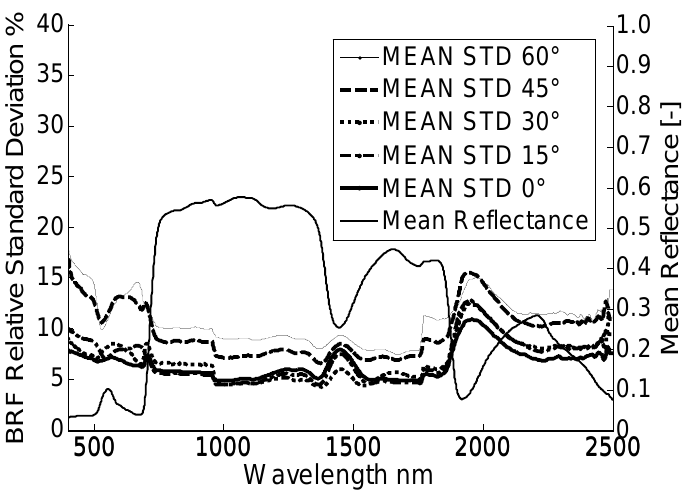
Figure 2. Relative standard deviation in % of the mean BRF of all 12 azimuth sensor positions for sensor zenith at 0°, 15°, 30°, 45°, and 60°. The light source is at 15° zenith and 0° azimuth. The mean reflectance among the 12 azimuth sensor position is presented with a thin solid line with the reflectance values on the right